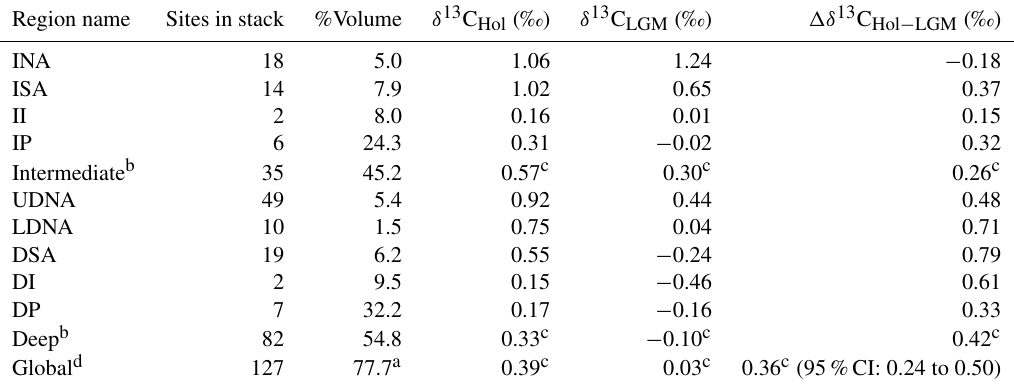
Table 1. Regional stack information. The total volume represented by the global stack of all nine regions (spanning 0.5–5km and excluding shallow inland seas, the Southern Ocean, and the Arctic Ocean) is 77.7% of the whole ocean. The volume of each region is listed as a percent of the global stack volume (rather than whole ocean volume). For each stack we list its δ 13 C value at the LGM (20ka), Holocene (6ka), and the Holocene δ 13 C minus LGM δ 13 C difference. The 95% confidence interval for the global mean δ 13 C change is provided in parentheses. The full time series for each stack is provided in the Supplement.